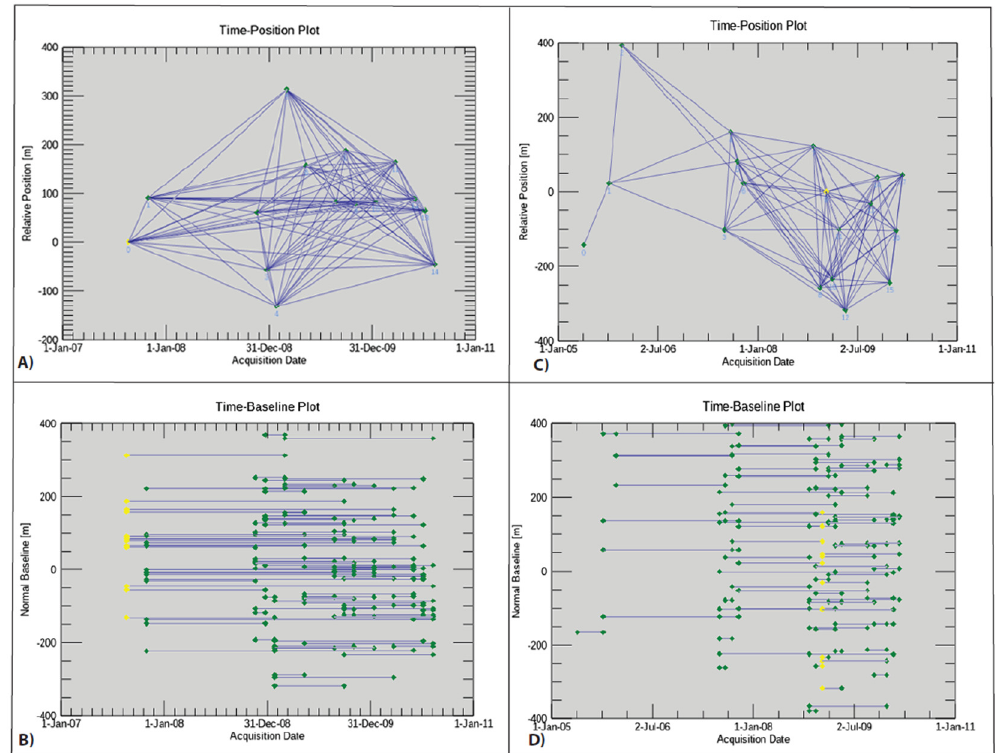
Figure 3. Small Baseline Algorithm (SBA) network representing a master and slaves interferogram that are linked to each other only when the normal and temporal baseline values are within the input thresholds. ( A , B ) show the descending tract 006 orbit connection graph representing all the ASAR co-registered to the 10 October 2007 acquisition date, anticipated as a super master image; ( C , D ) show the ascending tract 257 orbit connection graph representing all the ASAR co-registered to the 9 January 2007 acquisition date anticipated as a super master image.